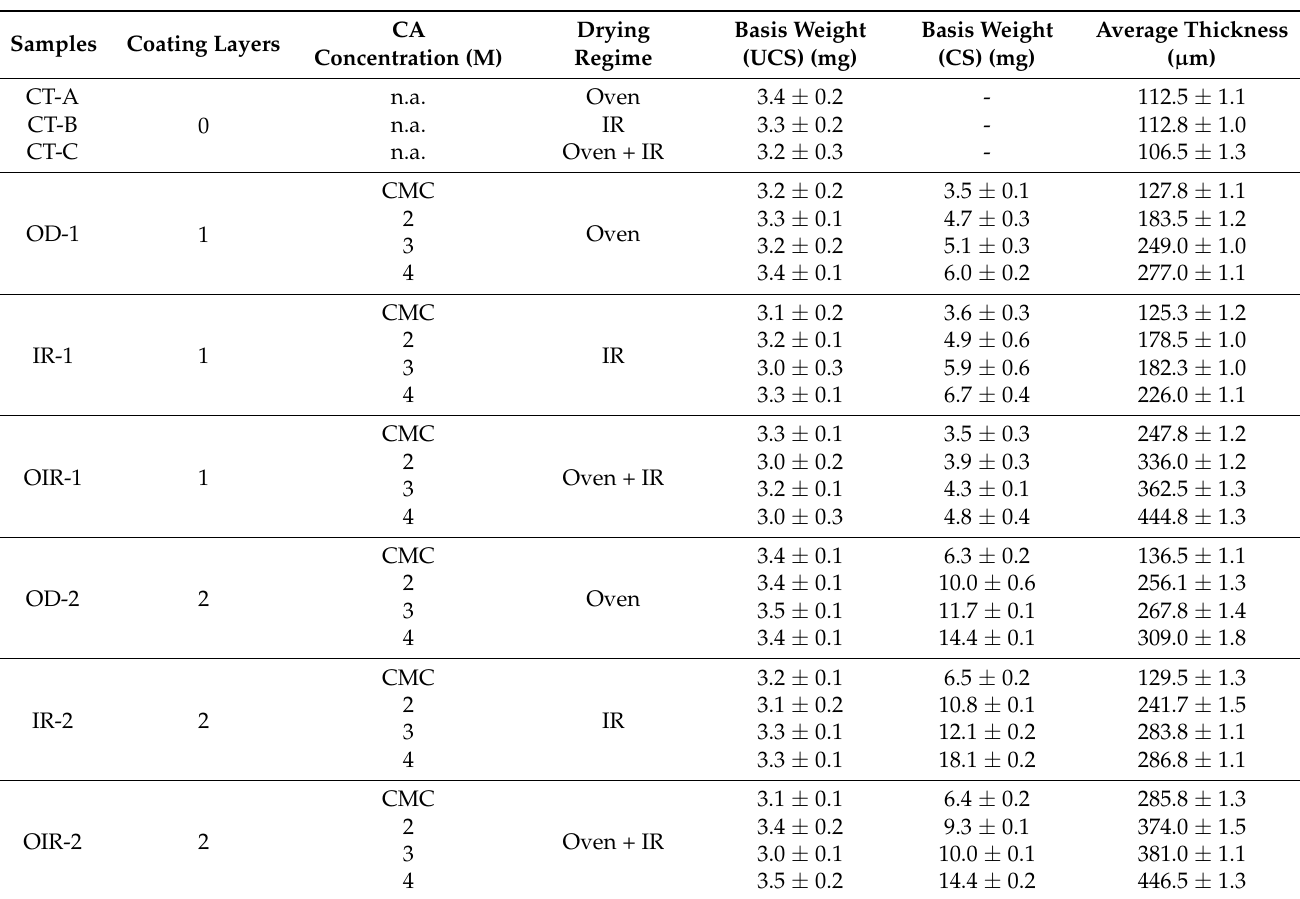
Table 3. Physical measurement of uncoated and coated cotton thread